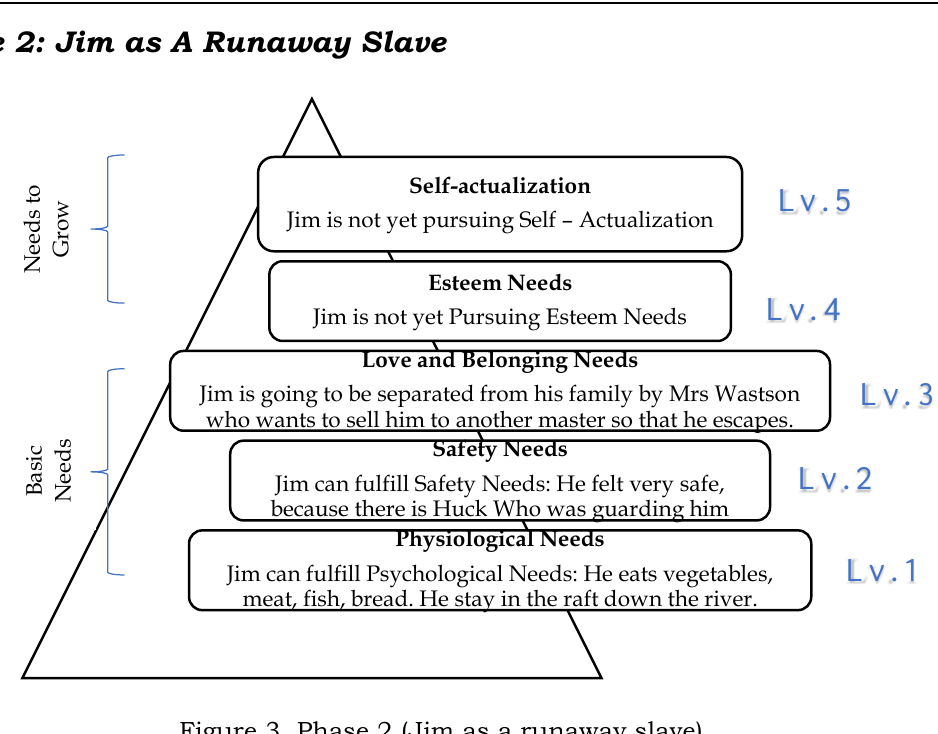
Figure 3. Phase 2 (Jim as a runaway